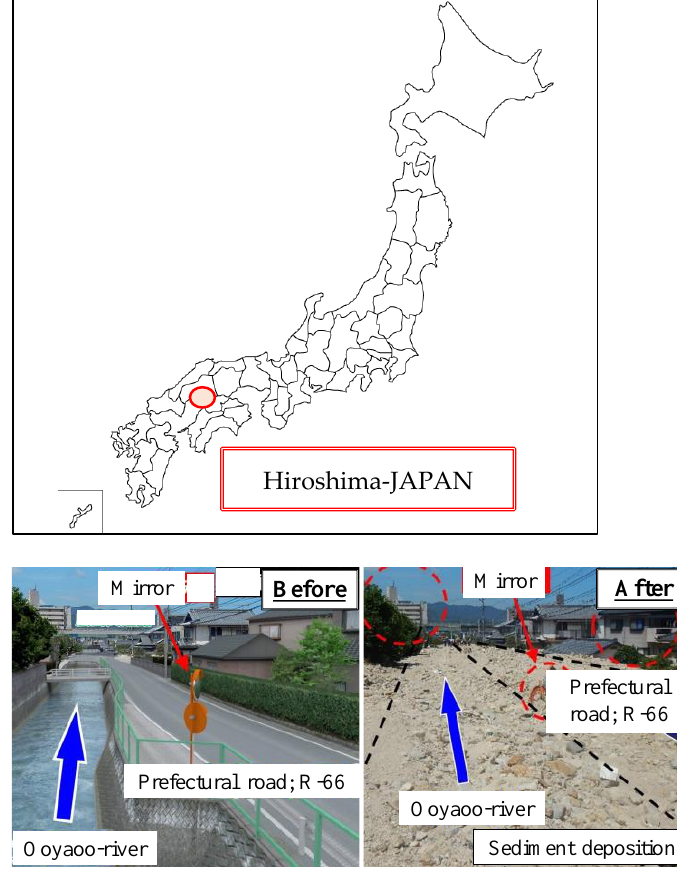
Figure 1. Damage caused by sediment and wood debris (H30, Hiroshima: Oya Okawa). Left : before the disaster; right : after the disaster [2].